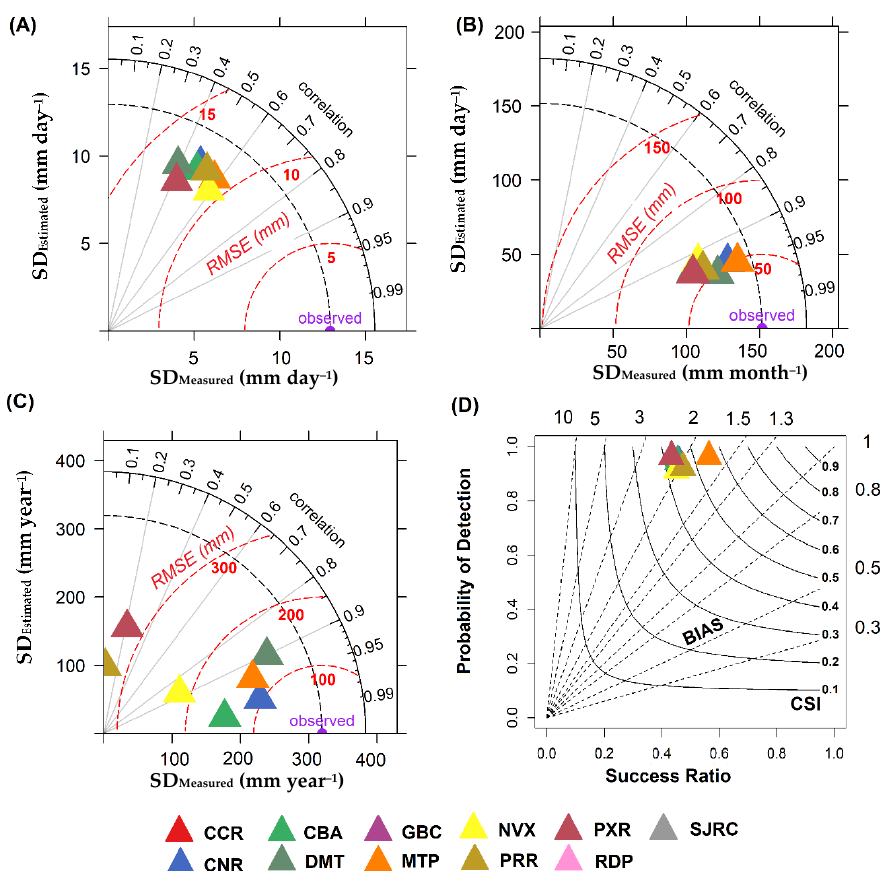
Figure 9. Taylor diagrams showing the comparisons of ( A ) daily (mm day −1 ), ( B ) monthly (mm month −1 ), and ( C ) annual (mm year −1 ) measured and estimated precipitation, as well as ( D ) the performance diagram of the GPM product at each of the weather stations in the state of Mato Grosso, Brazil. In panels ( A – C ), the Pearson correlation coefficient (r) was represented by the azimuth angle (black outlines), the RMSE was represented by the red dashed outlines, and the standard deviation (SD) was indicated by the x and y axes, respectively. In panel ( D ), the detection probability (POD) is represented on the x and y axes; the BIAS was indicated by the dashed black lines; and the critical success index (CSI) was represented by continuous black lines. For ( A ), the daily values for the entire study period were averaged, while for ( B ), the total monthly values for all months during the study period were averaged, and the annual values in ( C ) were the annual values averaged for all years during the study period.